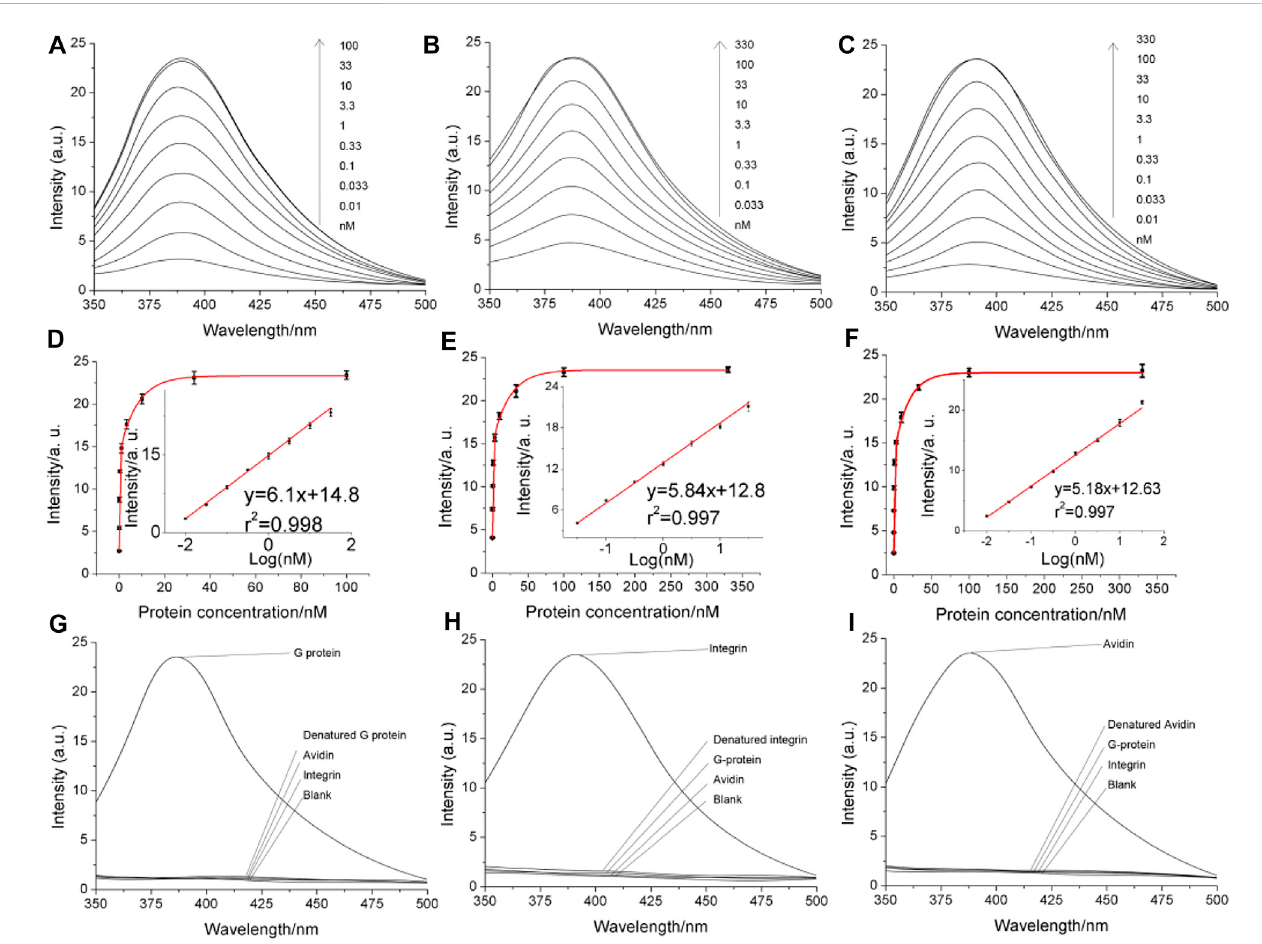
FIGURE 4 Analyticalperformanceoftheproposedmethoddirectlyusingthe fl uorescentsignalofthedi-tyrosineproduct.Panels (A – C) arethe fl uorescentspectra obtained in detecting serially diluted G-protein, integrin and avidin, respectively. The concentrations are marked on the graph. Panels (D – F) are quantitative curves obtained by plotting the fl uorescent peak signals as a function of the protein concentration. The insets are the linear range. The error bars indicate the standard deviation ( n = 3). Panels (G – I) are the speci fi